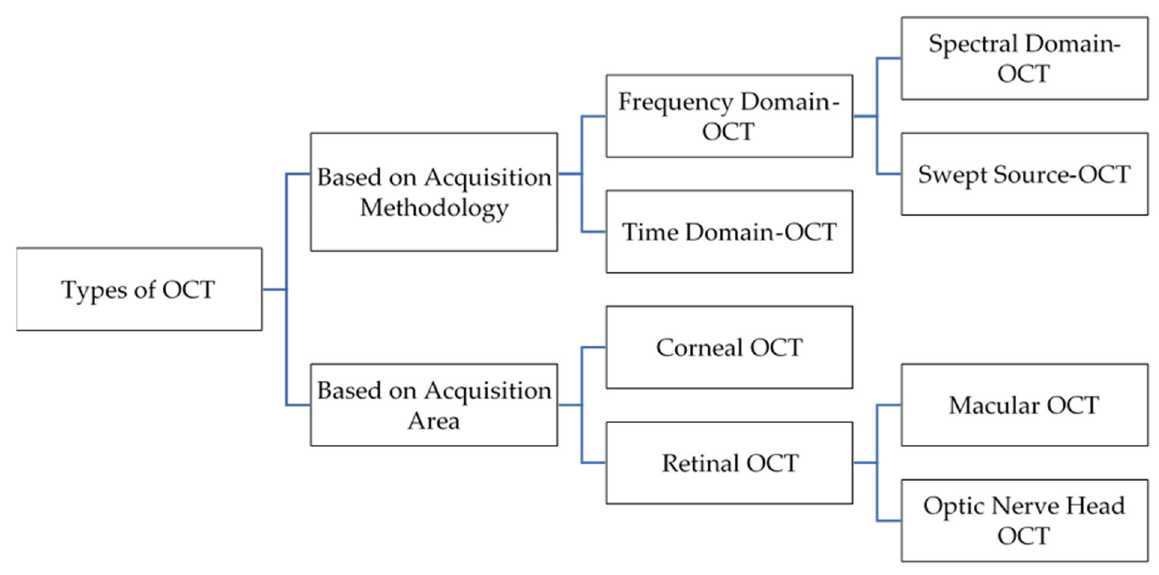
Figure 2. Classification of different types of OCT.